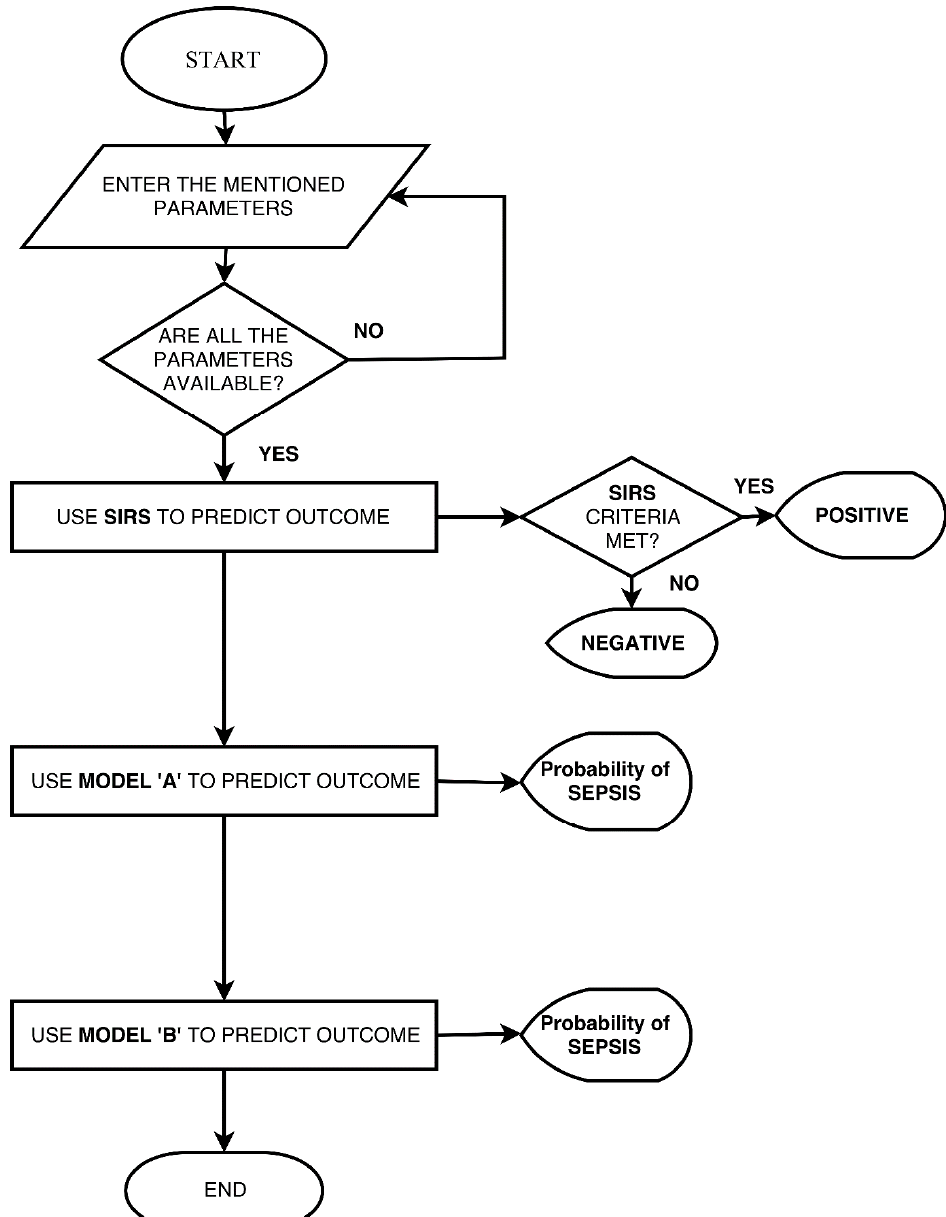
Figure 3. Flow chart showing the operation of the mobile application.